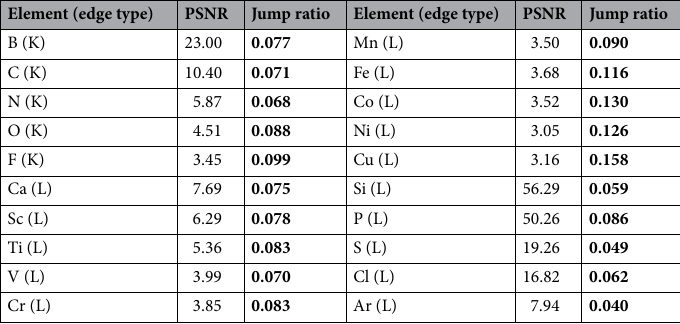
Table 4. Detectable PSNR and jump ratio. Significant values are in